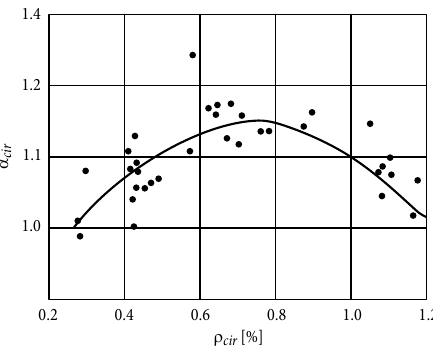
Fig. 4. The effect of the spiral wire reinforcement ratio r cir on the efficiency coefficient of annular reinforcement a cir by Eq.